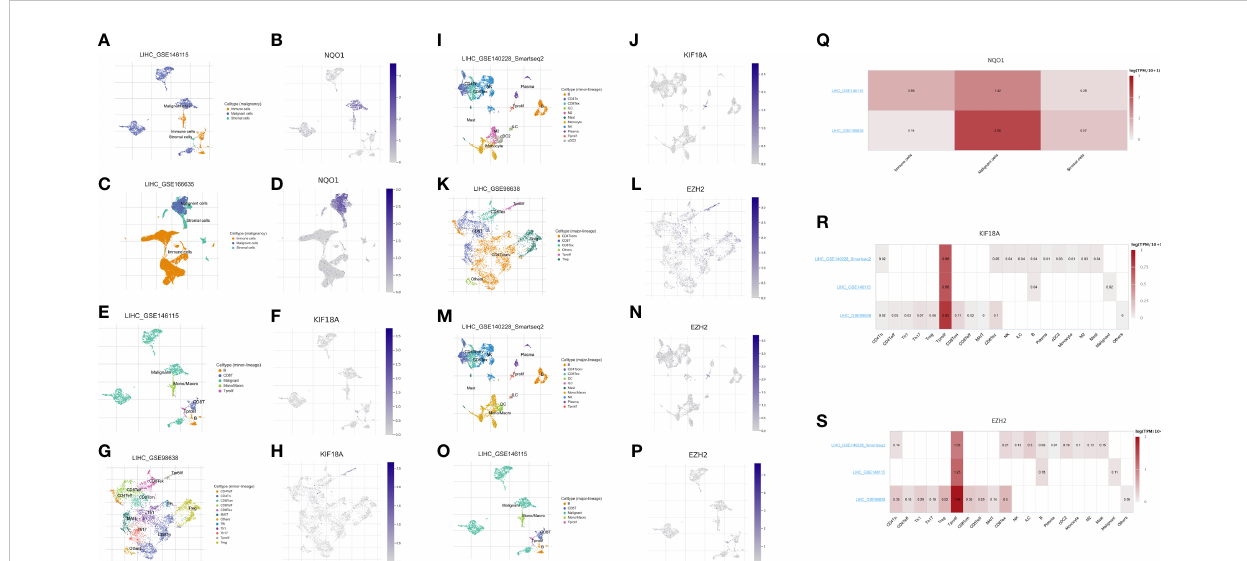
FIGURE 9 Expression of 3 anoikis-related genes in LIHC TME-associated cells. (A, C) The cell types and their distribution in LIHC_GSE146115 and LIHC_GSE166635 datasets. (B, D) Distribution of NQO1 in different cells in LIHC_GSE146115 and LIHC_GSE166635 datasets. (E, G, I) The cell types and their distribution in LIHC_GSE146115, LIHC_GSE98638 and LIHC_GSE140228 datasets. (F, H, J) Distribution of KIF18A in different cells in LIHC_GSE146115, LIHC_GSE98638 and LIHC_GSE140228 datasets. (K, M, O) The cell types and their distribution in LIHC GSE98638, LIHC_GSE140228 and LIHC_GSE146115 datasets. (L, N, P) Distribution of EZH2 in different cells in LIHC GSE98638, LIHC_GSE140228 and LIHC_GSE146115 datasets. (Q) Expressions of NQO1 in LIHC_GSE146115 and LIHC_GSE166635 datasets. (R) Expressions of KIF18A in LIHC_GSE146115, LIHC_GSE98638 and LIHC_GSE140228 datasets. (S) Expressions of EZH2 in LIHC GSE98638, LIHC_GSE140228 and LIHC_GSE146115